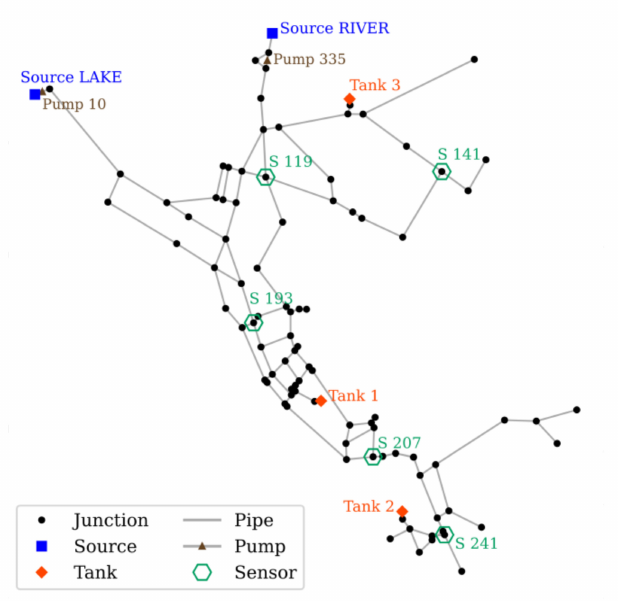
Figure 10. Application network layout and sensor